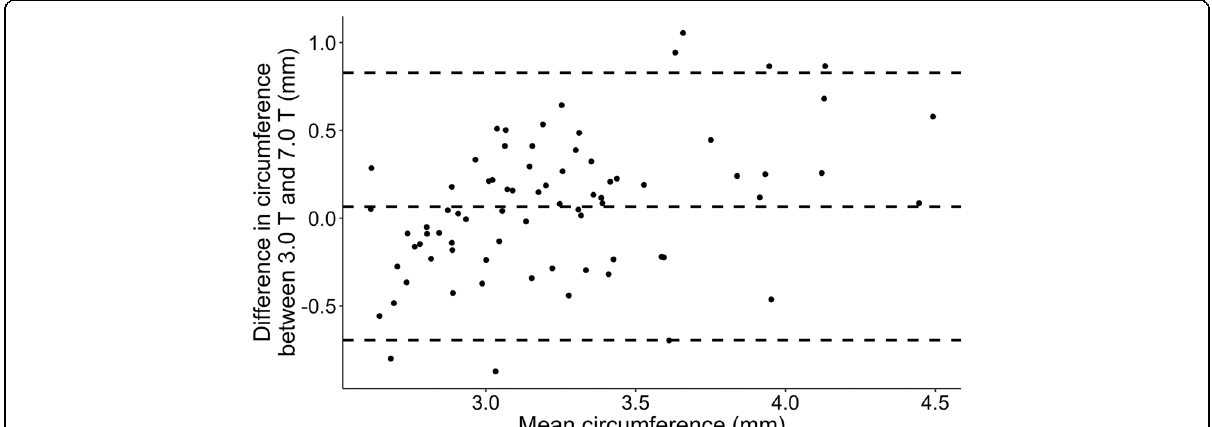
Fig. 3 Bland-Altmann plot depicting agreement between circumference measurements of intradural MMA 3.0 T vs 7.0 T within subject, within drug, within time point analyzed with LAVA software. Each point represents difference in circumference between 3.0 T and 7.0 T as a function of mean of the two measurements. Dashed lines are overall mean of differences